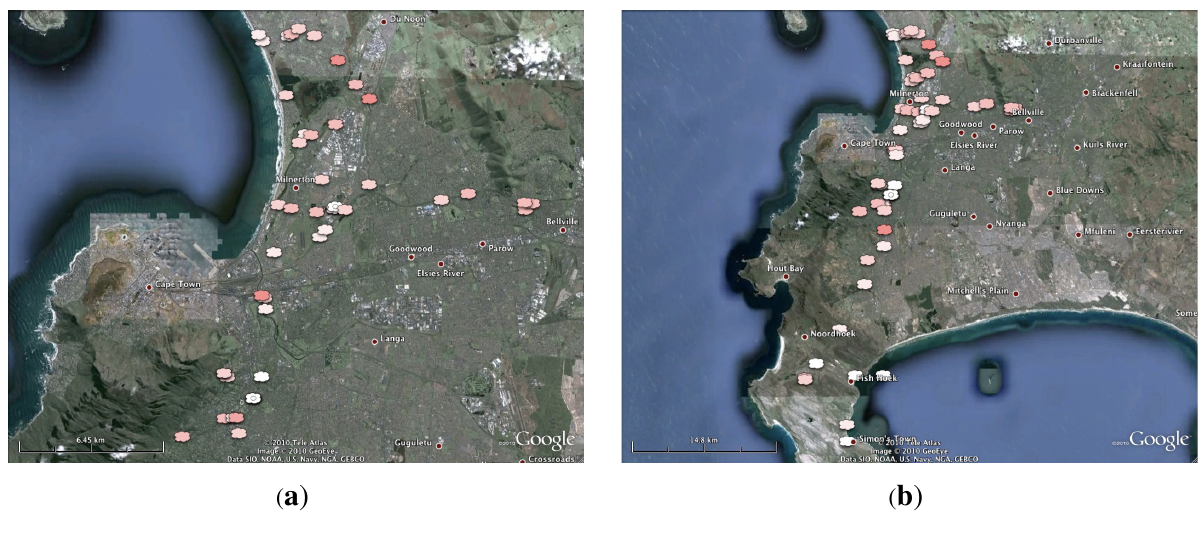
Figure 9. Pollution Mapping. ( a ) Pollution Map (First Day); ( b ) Pollution Map (Second